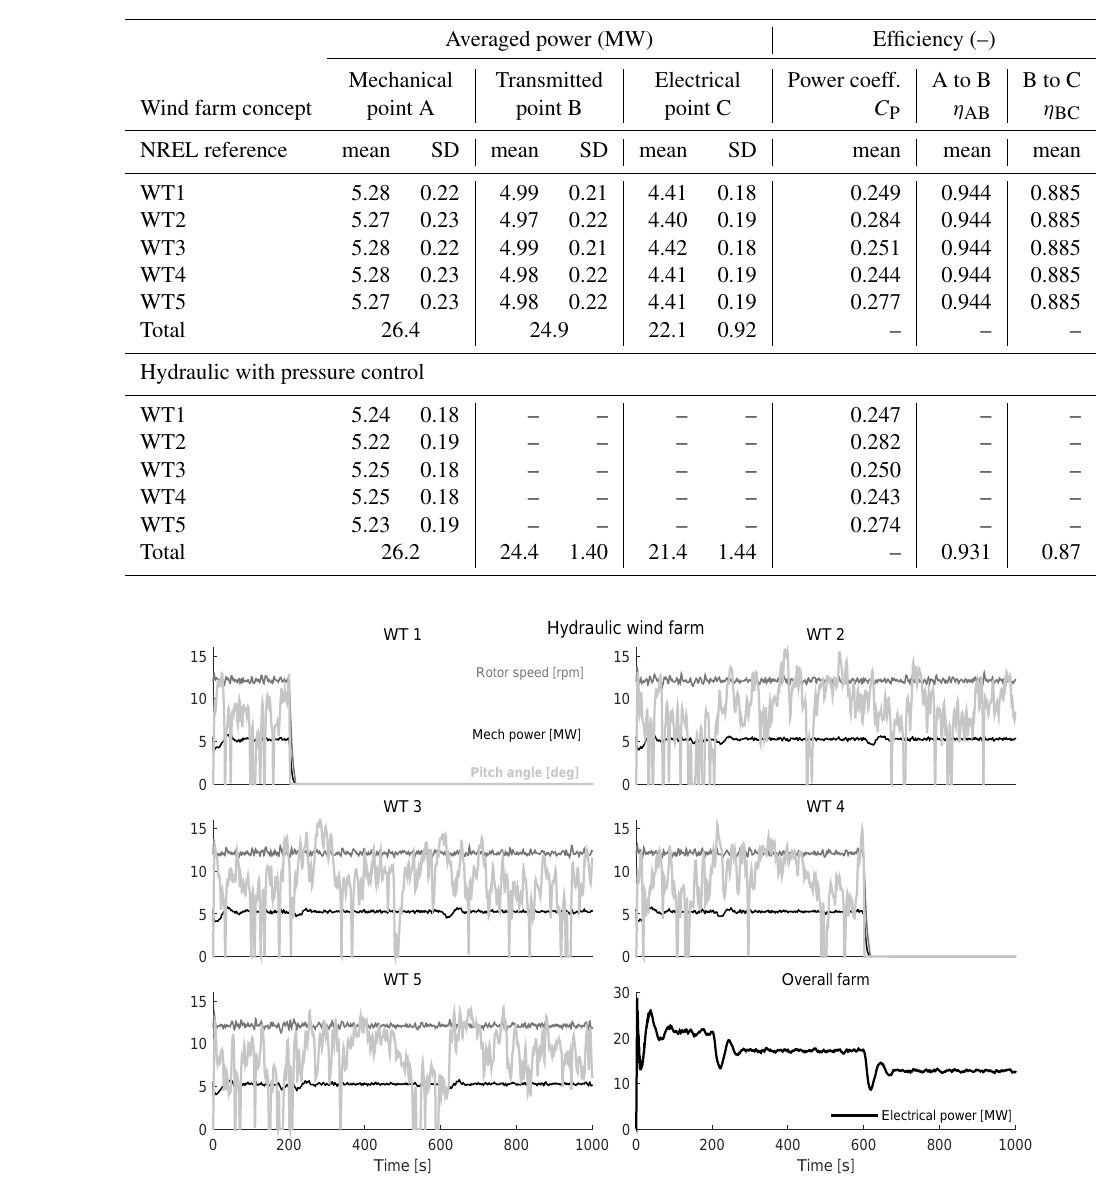
Figure 18. Time domain results for a hydraulic wind farm subject to a wind field with a mean speed of 15ms − 1 and 12% turbulence intensity and full stop of turbines WT1 and WT4 at 200 and 600s